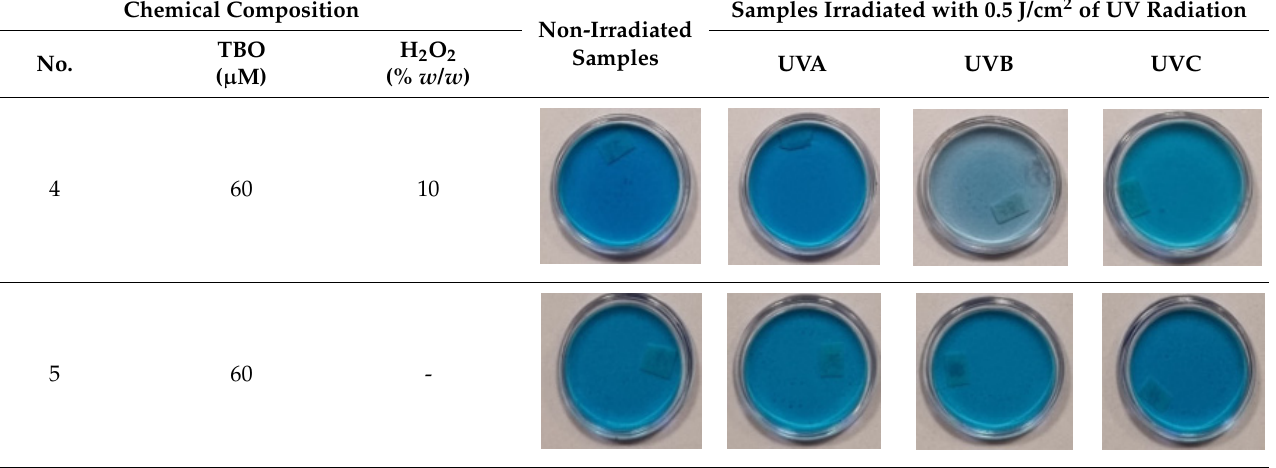
Further in this study, three dosimeter compositions (1, 3 and 4; see Table 1) were selected to assess the effect of TBO and H 2 O 2 concentrations on the UVB dose–response of the dosimeter (Figure 2). The same threshold dose (0.01 J/cm 2 ) and dynamic dose range (0.01–3 J/cm 2 ) were obtained for all compositions, and the dose sensitivities (slopes of the linear regressions of Absorbance = f(dose)) were equal to − 1.912 ± 0.498 cm 2 /J, − 1.432 ± 0.057 cm 2 /J and − 1.997 ± 0.331 cm 2 /J for compositions 1, 3 and 4, respectively (Table 2). Composition 3 was characterized by a wider linear dose range (0.5–2 J/cm 2 ) compared to composition 1 (0.5–1 J/cm 2 ) and composition 4 (0.5–1.5 J/cm 2 ) (Table 2). After analysing the results, composition 3 was selected for further research because of the higher absorbance of the non ‐ irradiated sample compared to composition 1, and wider linear dose range and a correlation coefficient (R 2 ) closer to 1 compared to composition 4.